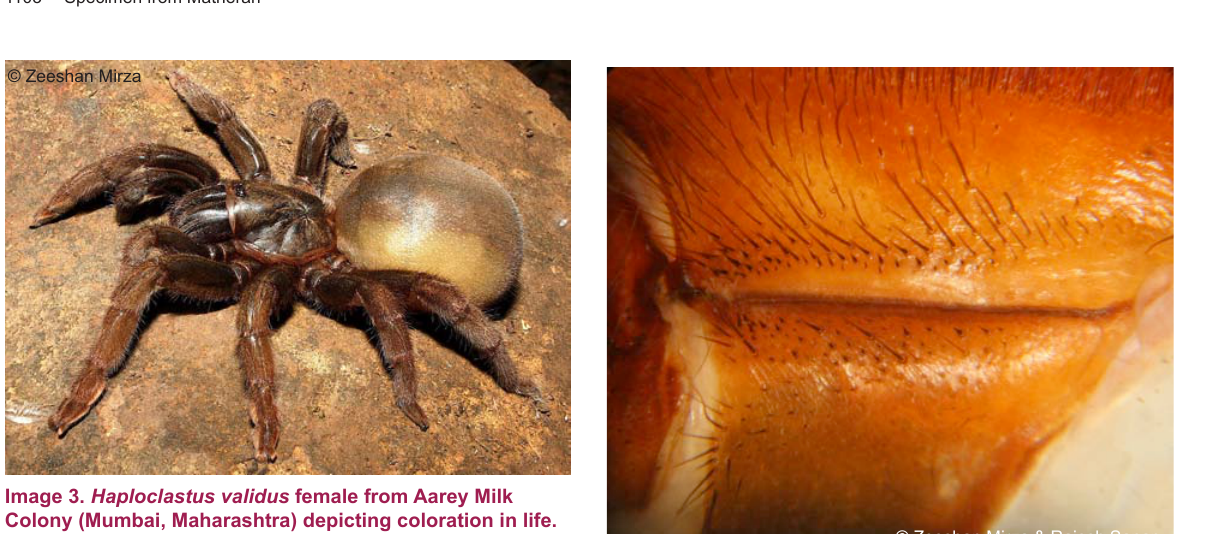
Metatarsus Tarsus